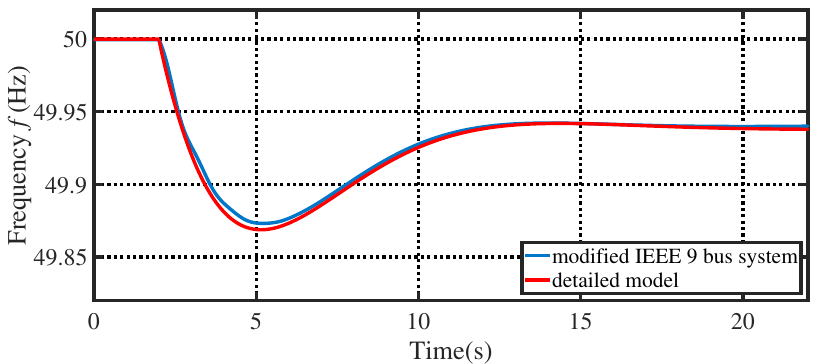
Figure 12. Grid frequency dynamics of the modified IEEE 9-bus system and the detailed model during the under-frequency event.